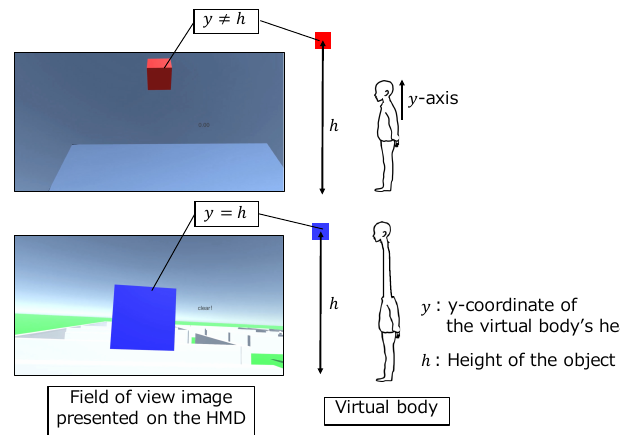
Figure 15. Task performed in the evaluation